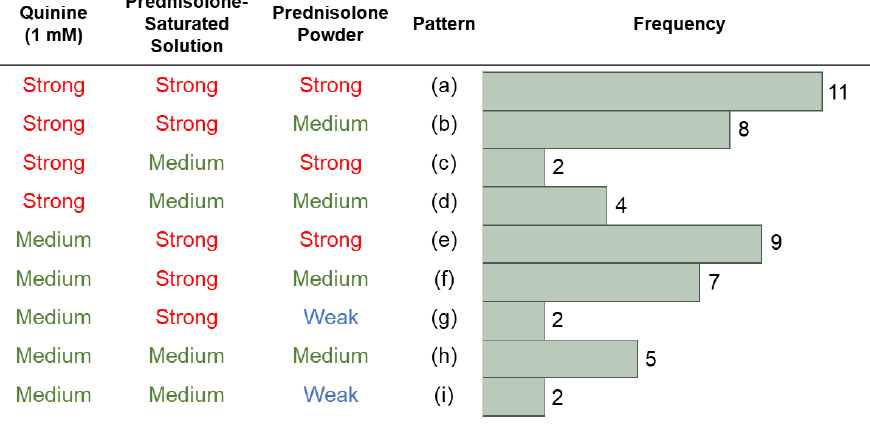
Figure 2. Patterns of subjects’ bitterness perception.